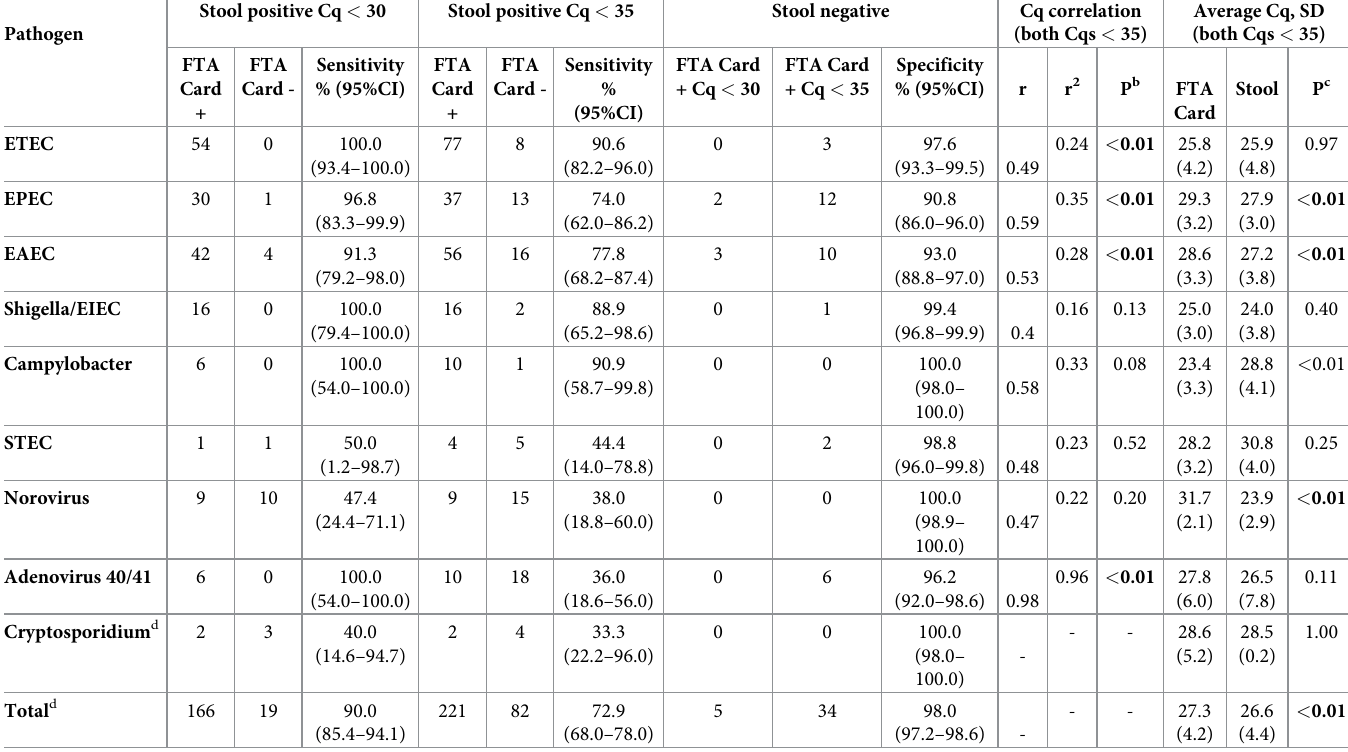
Table 2. Comparison of enteropathogen detection on 187 paired stool samples and stool smears stored on FTA Whatman Elute Cards using the TaqMan Array Card PCR platform. PCR results on stool samples used as reference standard a .